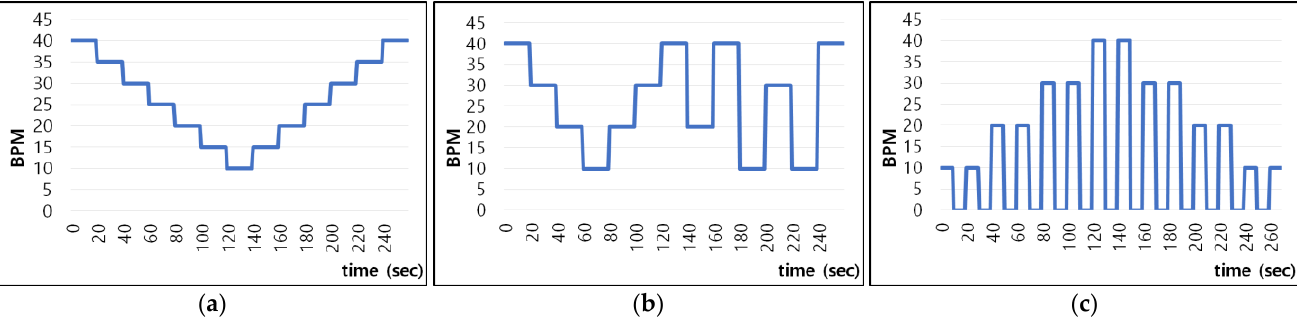
Figure 6. Bpm change in guidelines provided to subjects to acquire training data: ( a ) sequential change in breathing rate; ( b ) rapid change in breathing rate; ( c ) patterns involving apnea.